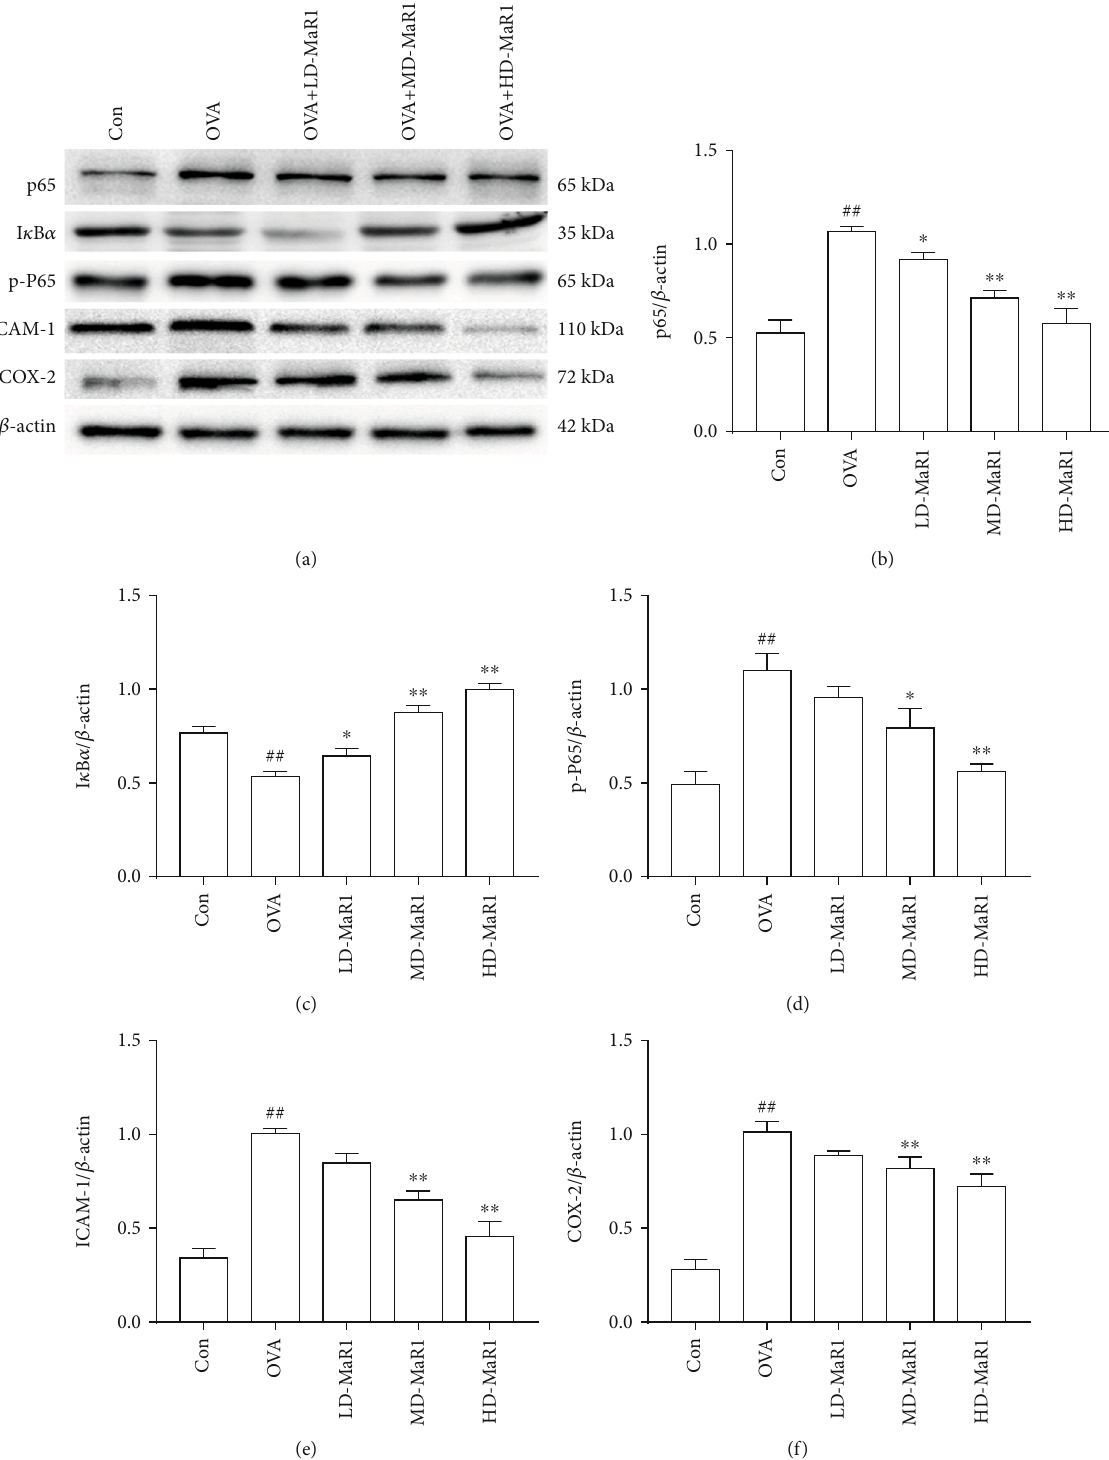
Figure 6: E ff ects of MaR1 on OVA-induced NF- κ B activation in lung tissue. (a) p65, I κ B α , p-P65, ICAM-1, and COX-2 protein expression representative Western blot images. (b – f) The relative density quanti fi cations of p65, I κ B α , p-P65, ICAM-1, and COX-2. The results were expressed as the ratio of p65, I κ B α , p-P65, ICAM-1, and COX-2 relative to β -actin, respectively. Data expressed as mean ± SEM ( n = 6/group ). ## P < 0 : 01 , # P < 0 : 05 vs. the control group; ∗ P < 0 : 05 , ∗∗ P < 0 : 01 vs.